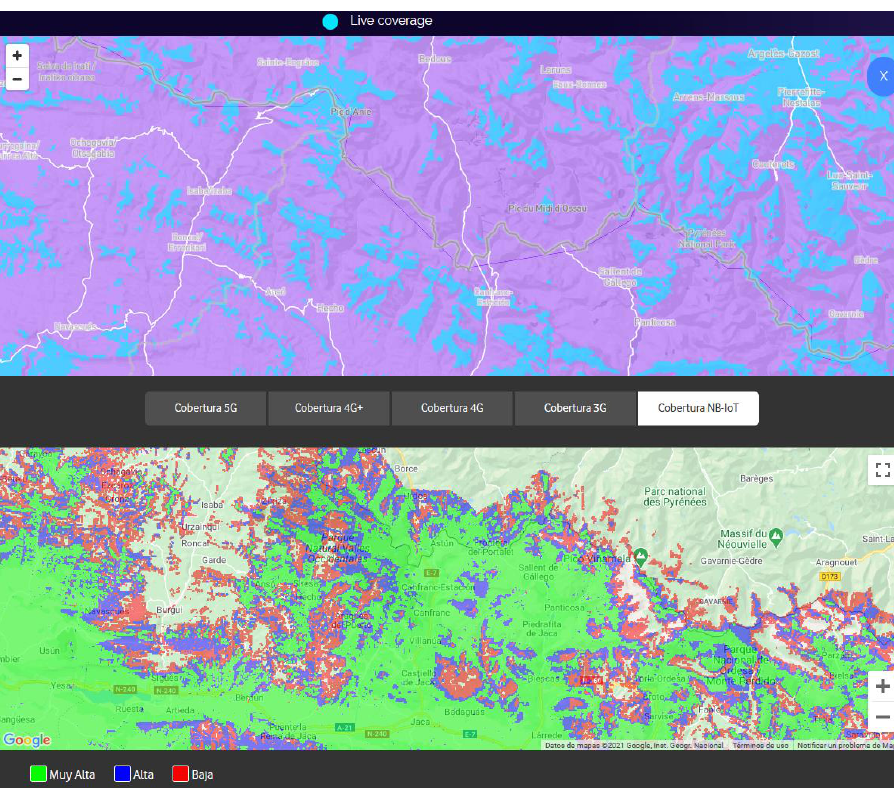
Figure 2. Coverage provided by SigFox (up) and NB-IoT by Vodafone (down, and probably the best one in Spain) in the Pyrenees area in Spain (source websites from SigFox and Vodafone, December